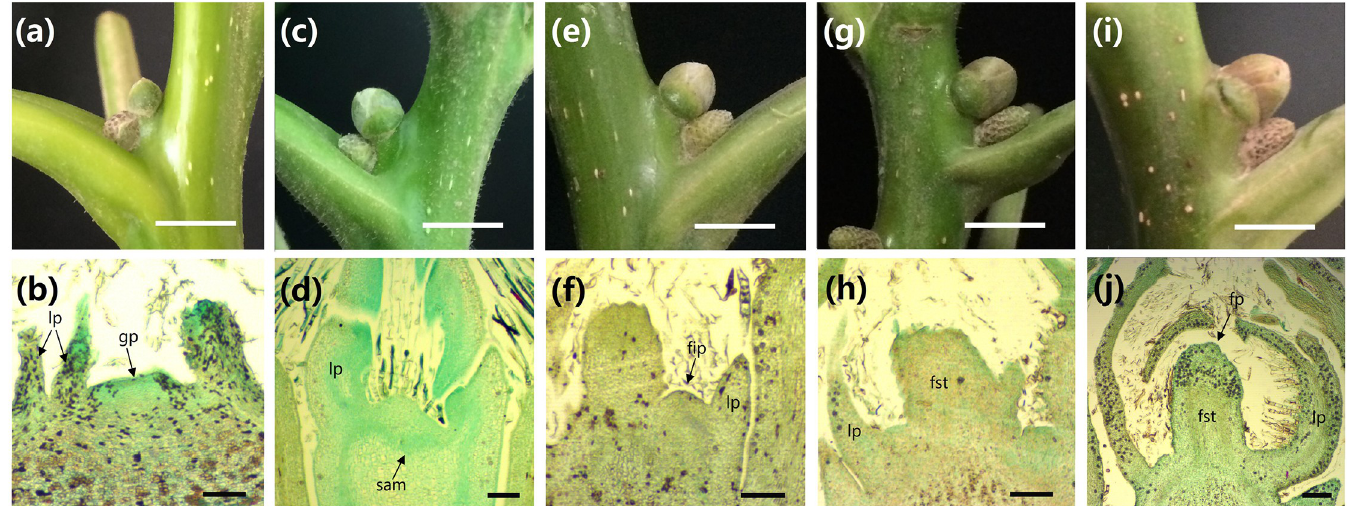
Fig 1. Morphological characteristics of the ‘Wen 185’ female flower bud. a, c, e, g and i present the phenotypic characteristics of five different developmental stages of female flower buds; b, d, f, h and j represent the internal morphological differentiation characteristics of five different developmental stages of female flower buds, a and b: The bud sprouted; c and d: Apical meristem began to flatten and sag; e and f: Spire turn rounded and shape protuberance; g and h: Flower stalk primordium development stage; i and j: Female flower primordium development stage. Ruler: 100 μ m. lp, leaf primordia; gp, growth point; sam, apical meristem; fip, female flower inflorescence primordium; fst, flower stalk; fp, female flower primordium.